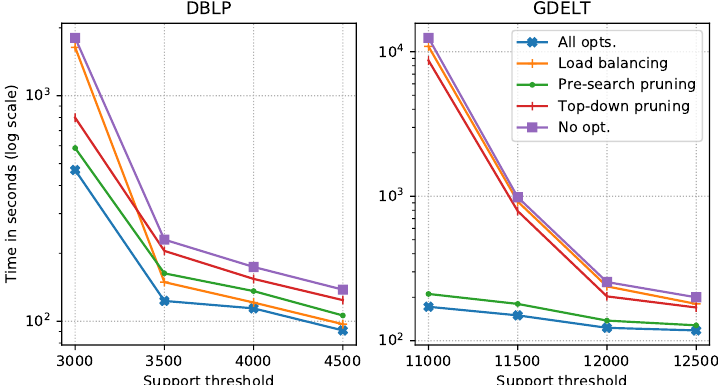
Figure 8. The effect of each optimization. All opts. : All optimization enabled; Load balancing: Only load balancing enabled; Pre-pruning: Only pre-search pruning enabled; Top-down prune: Only top-down pruning enabled; No Opt.: No optimization strategies involved.